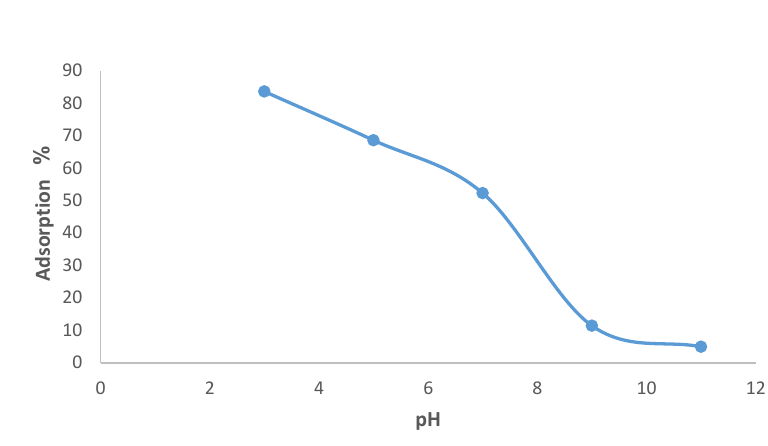
Effect of contact time